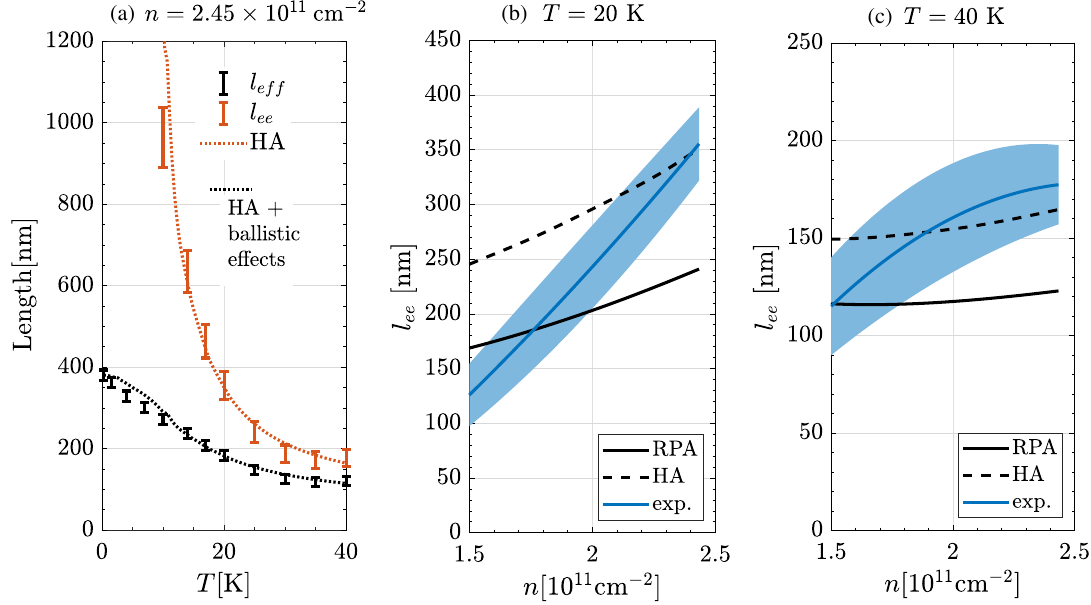
FIG. 8. (a) The measured l shown by error bars, compared to the theory with the Hubbard local field correction (dotted orange lines) ee described in Appendix F and the measured effective length l that contains low- T ballistic corrections, compared to the theory with the eff Hubbard local field correction (dotted black lines). See similar plots in Fig. 3, where the dotted theory curves are based on RPA. The density dependence of l at (b) T ¼ 20 K and (c) T ¼ 40 K in the Hubbard and RPA approximations compared to the experimentally ee measured values shown by the blue solid line. The shaded area depicts the uncertainty due to the possible variation of impurity concentration as discussed in Appendixes A and D. The correlation effects captured by HA but missed in RPA account for an approximately 50% increase in the interaction length yet do not explain the strong density dependence observed in the experimental